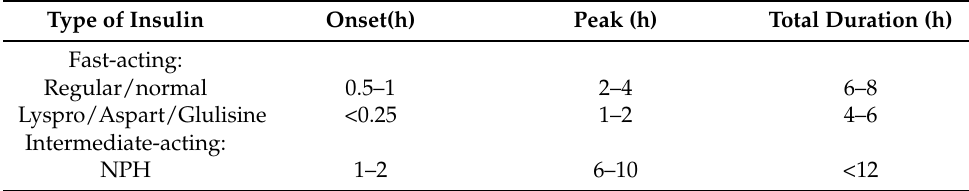
Table 3. Types of insulin and